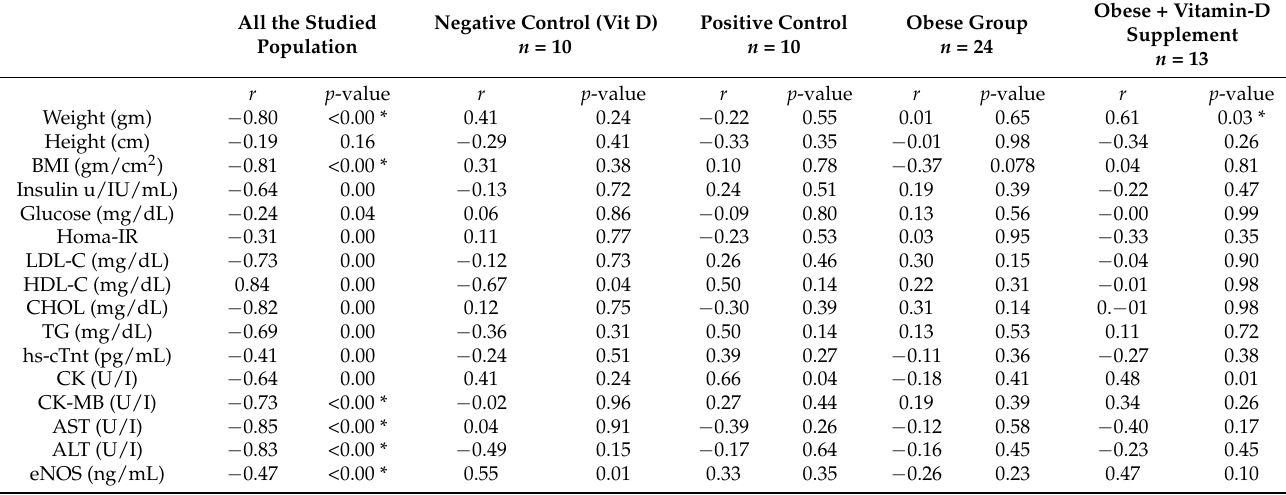
In Table 4, correlations of serum level of SMP-30 (the marker of cellular senescence) with all anthropometric and measured parameters are presented. There is a significant correlation in all anthropometric parameters with SMP-30 level except for height. SMP-30 level shows a negative correlation with weight and BMI. In the vitamin-D-supplemented obese group, there is a positive correlation between SMP-30 level and weight, while there is no significant correlation between the SMP-30 level and other parameters. Table 4. Correlation of SMP-30 (pg/mL) level with anthropometric and biochemical parameters. All the Studied